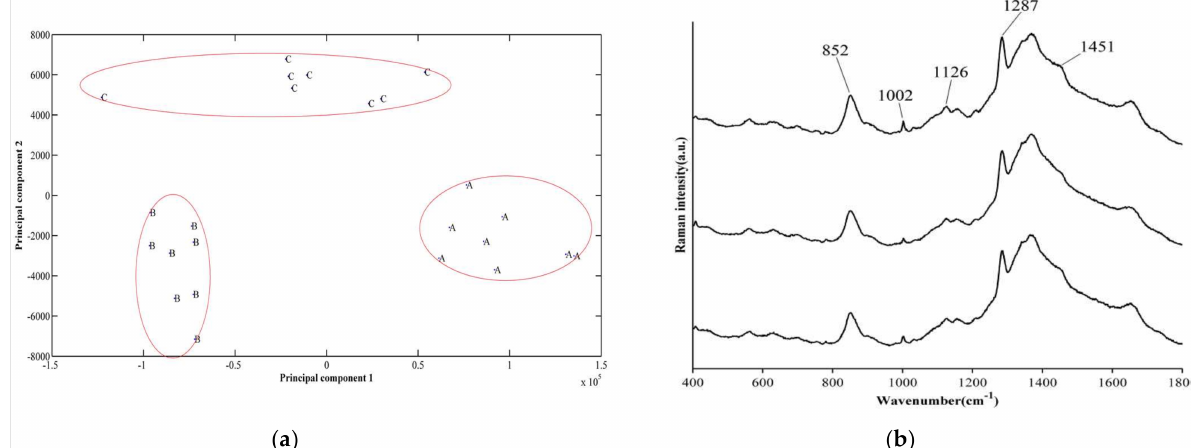
Figure 4. Comparison of the spectral features of C. sakazakii biofilms using Raman spectroscopy. ( a ) Principal component analysis of biofilm composition in C. sakazakii WT, ∆ ompF and cp ompF strains. ( b ) Comparison of the spectral features of C. sakazakii biofilms using Raman spectroscopy. (A): complement strains, (B): mutant, (C):